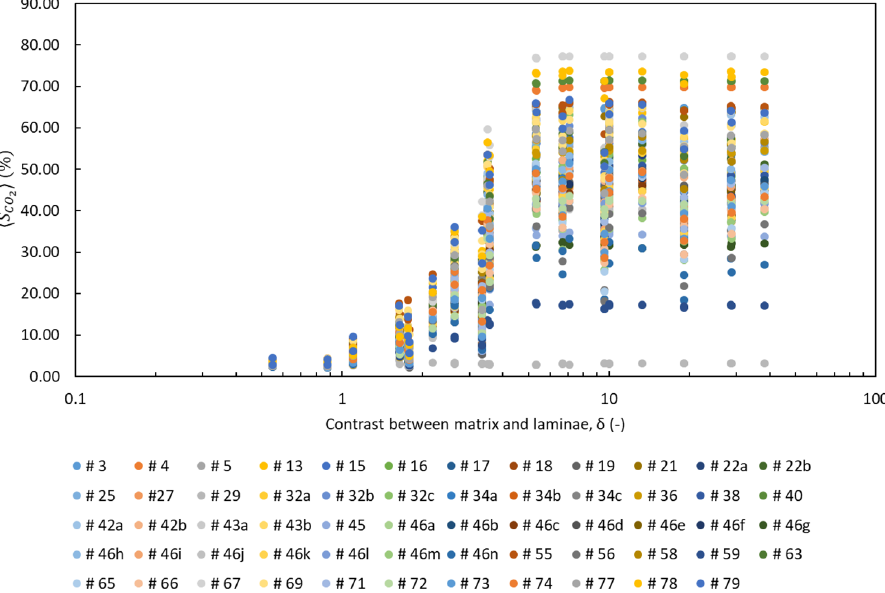
Figure 4. Mean domain CO 2 saturation ( (cid:31) S CO 2 (cid:30) ) as a function of the dimensionless grain size contrast parameter (δ) for different BAMs. Every data point is the average of 50 stochastic simulation runs. The legend shows the color of the data series for the 59 BAMs and their corresponding number as defined by Rubin and Carter 38